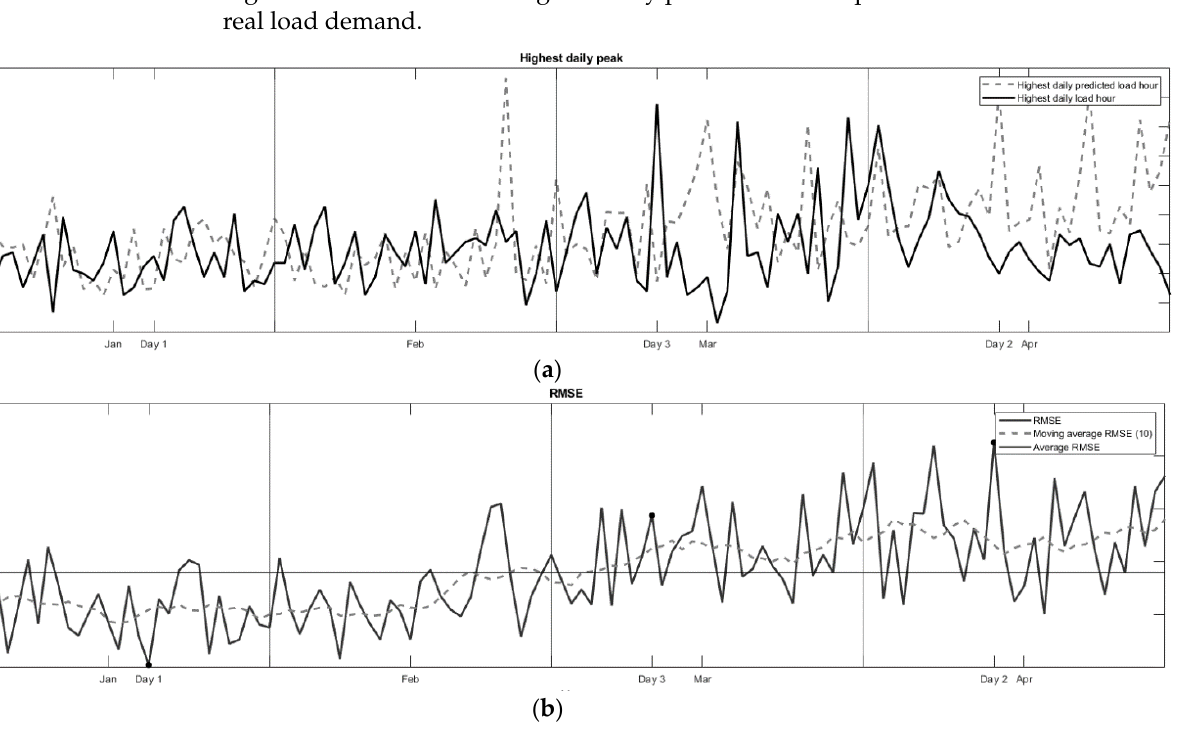
Figure 11. January-April 2022: ( a ) The highest daily peak hours in the predicated and target load demand; ( b ) the corresponding daily RMSE and the moving average for same period. Table 9. The highest load demand peak before and after the peak shaving operation from the three chosen days in the testing data set.